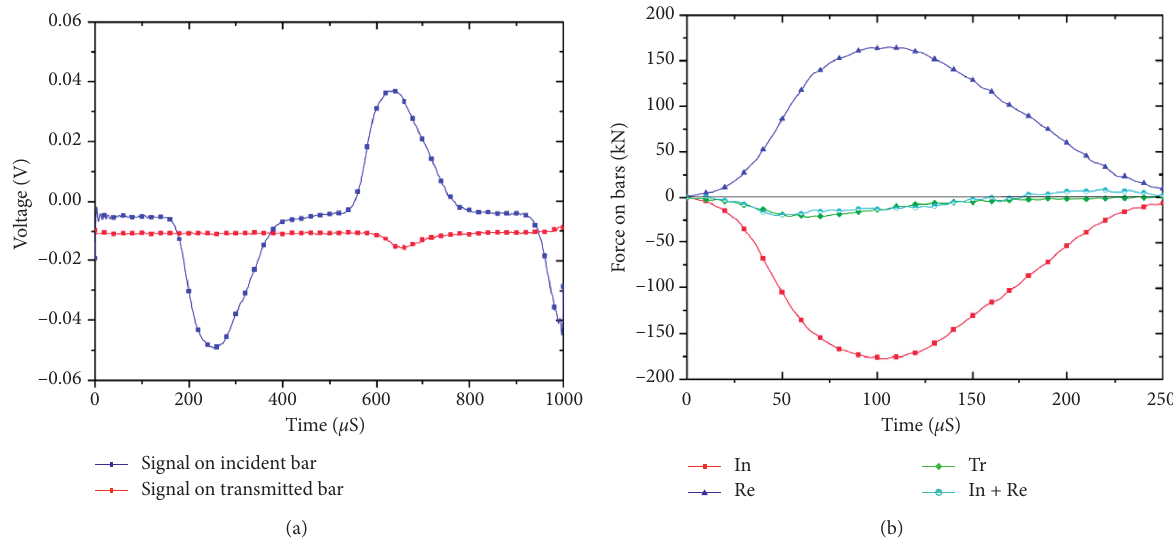
Figure 4: Experiential results of the dynamic Brazilian disc test at _ σ � 535GPa/s and β � 90 ° . (a) Raw data recorded from the gauges mounted on the bars and the specimen. (b) The incident (In.), reflected (Re.), transmitted (Tr.), and superposed (In.+ Re.) waves after the time shift by the three-wave